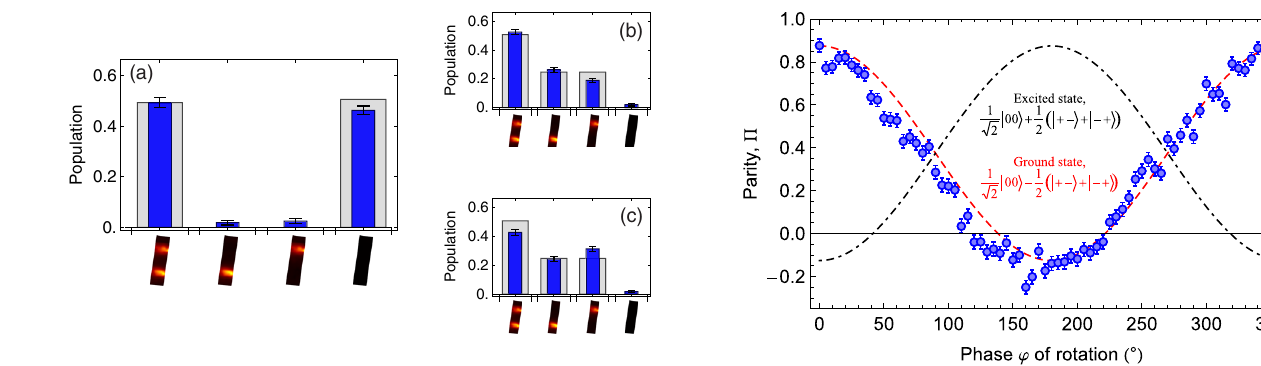
FIG. 6. Following an adiabatic ramp, the parity of the final state is measured as a function of the final rotation phase φ (see text for rotation protocol). Dashed and dot-dashed lines represent the theoretically expected values for the ground state, ffiffiffi p j 00 i = 2 − ðj − þi þ j þ − iÞ = 2 , and highest excited state, ffiffiffi p j 00 i = 2 þ ðj − þi þ j þ − iÞ = 2 , respectively. The phase of the oscillation reveals that the relative phases in the prepared state are consistent with the expected ground state.